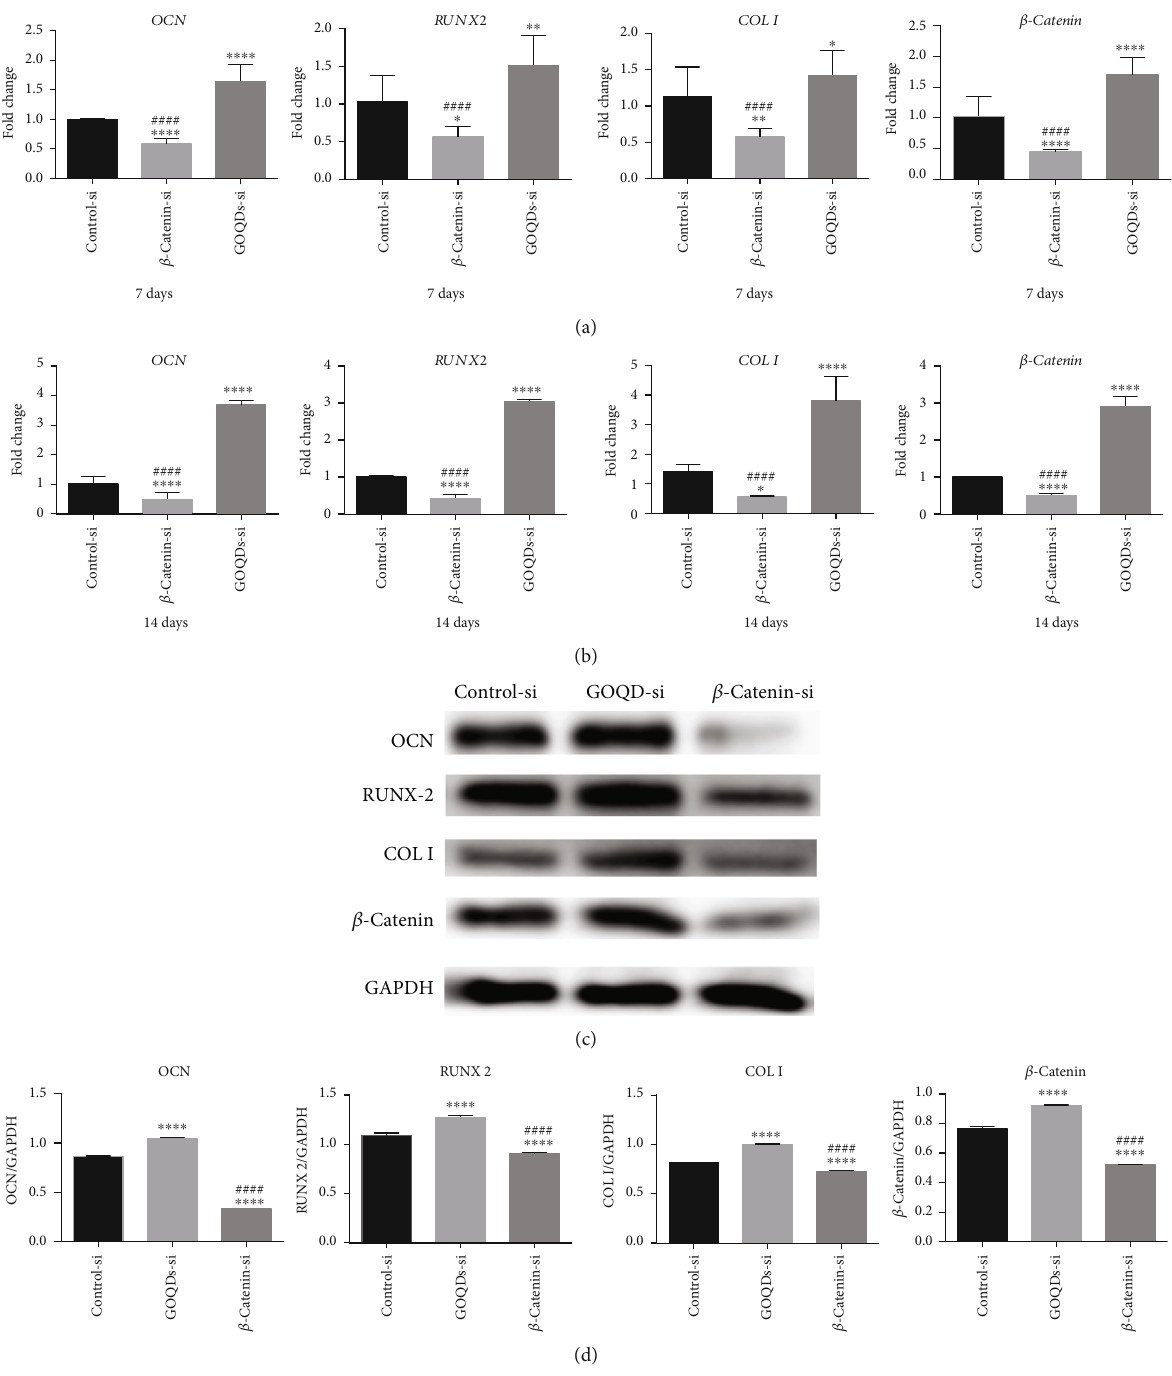
Figure 8: SHEDs were cultured in the osteogenic induction medium containing GOQDs. (a) mRNA extracted at 7 days. (b) mRNA extracted at 14 days. (c) Protein extracted at 14 days. (d) Quanti fi cation of protein levels. ∗ p < 0 : 05 , ∗∗ p < 0 : 01 , ∗∗∗ p < 0 : 001 , and ∗∗∗∗ p < 0 : 0001 vs. the control-si group. # p < 0 : 05 , ## p < 0 : 01 , ### p < 0 : 001 , and #### p < 0 : 0001 vs. the β -catenin-si